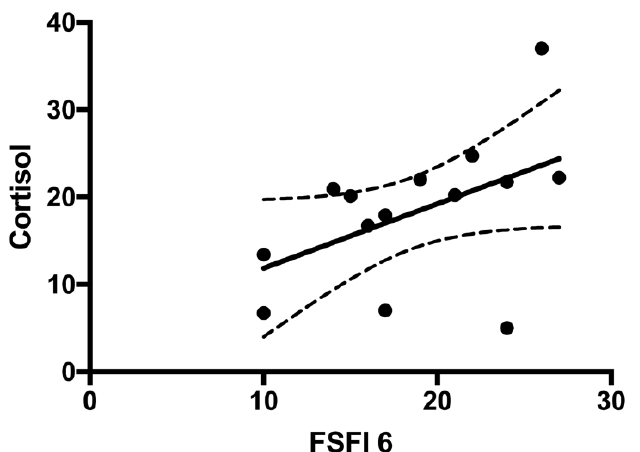
Figure 2. Correlation between FSFI-6 total score and serum cortisol levels in patients’ group (Spear- man correlation test; p = 0.03; r = 0.55).